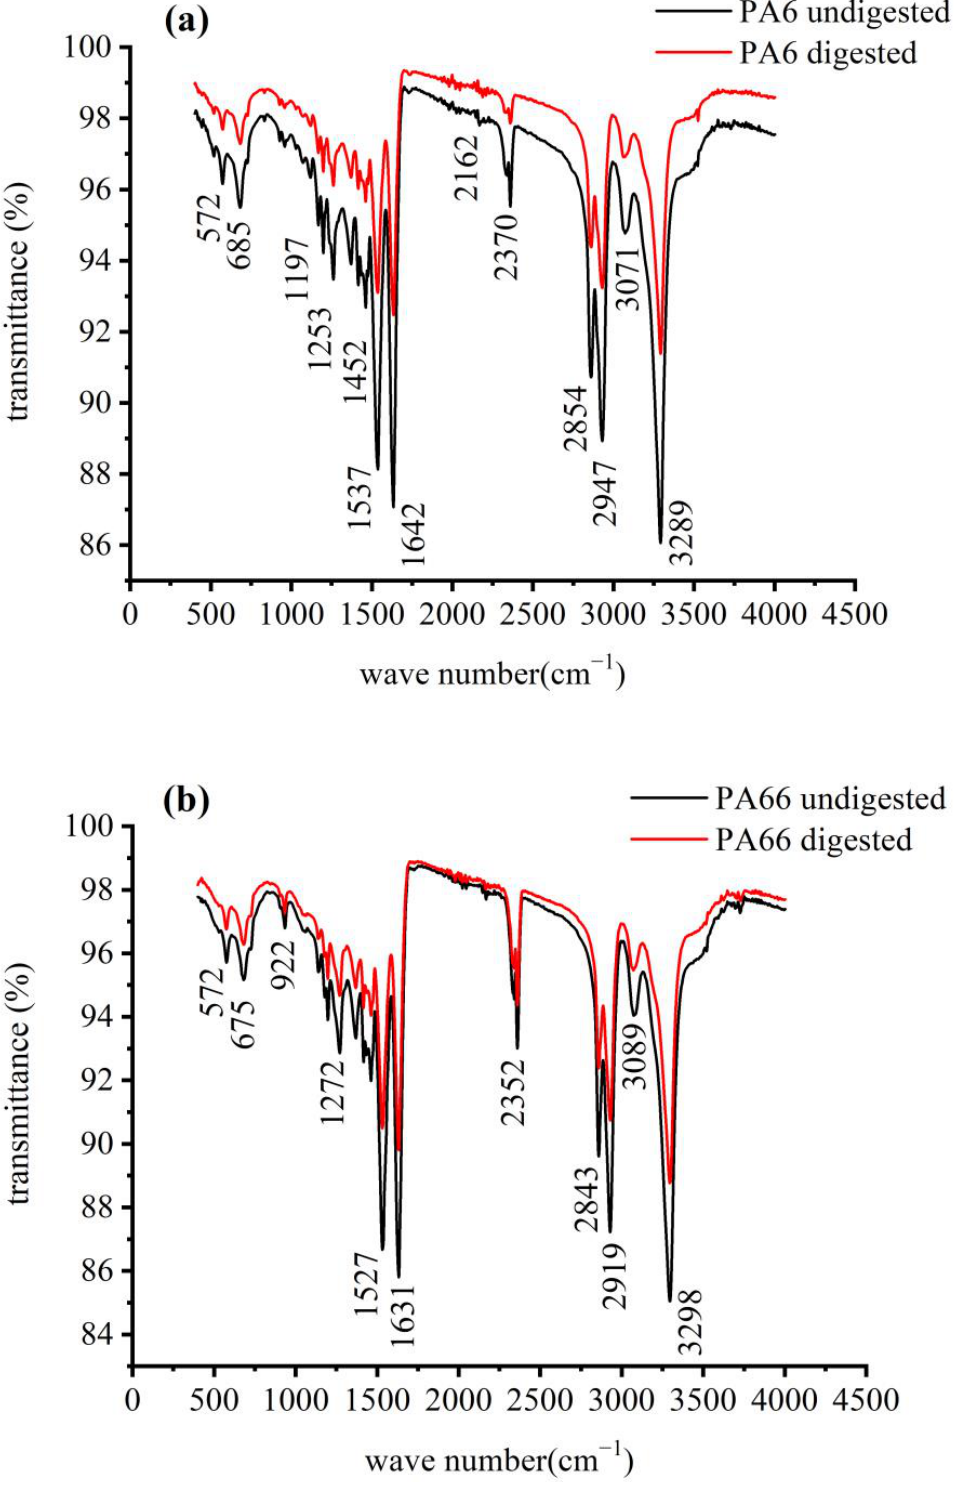
Figure 3. IR spectra of microplastics before and after digestion: ( a ) PA6; ( b ) PA66.